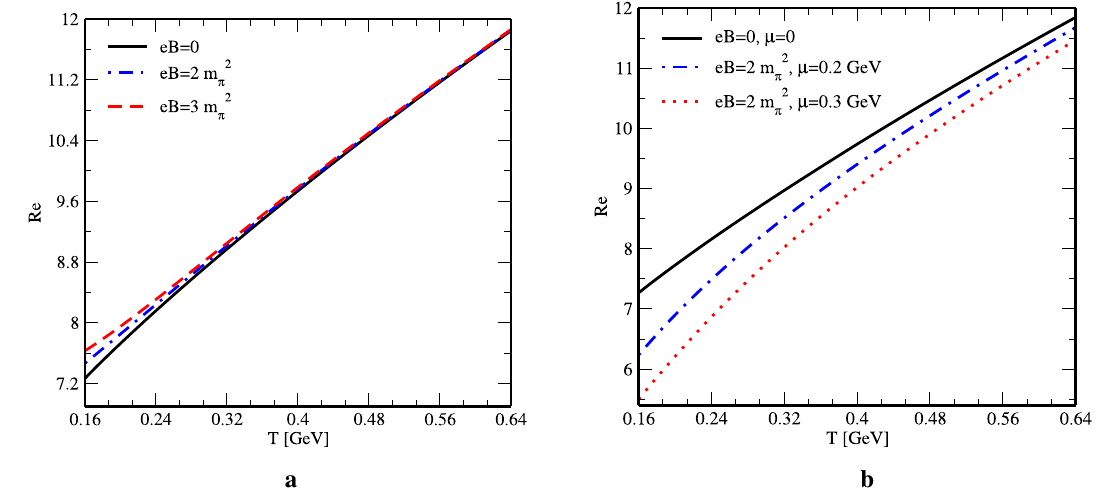
Fig. 6 The variation of the Reynolds number with temperature ( a ) in the presence of weak magnetic field and ( b ) in the presence of finite chemical potential